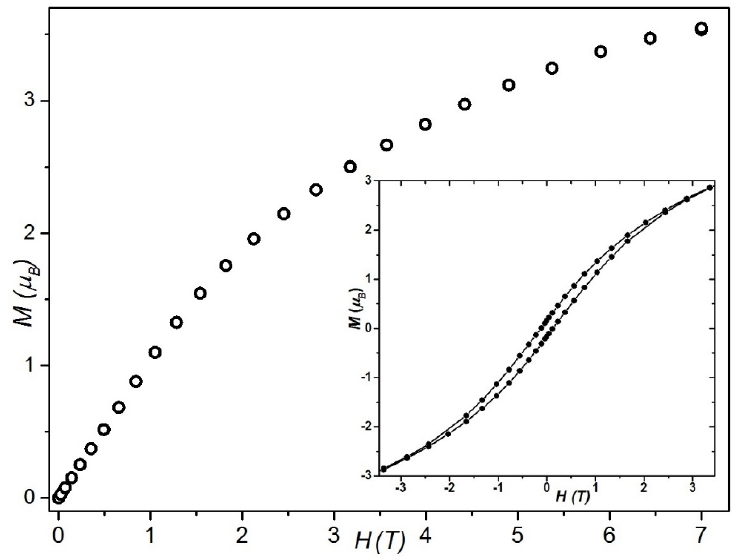
Figure 5. Initial magnetization vs field plot and magnetic hysteresis (inset) for 1 at T = 1.8 K.